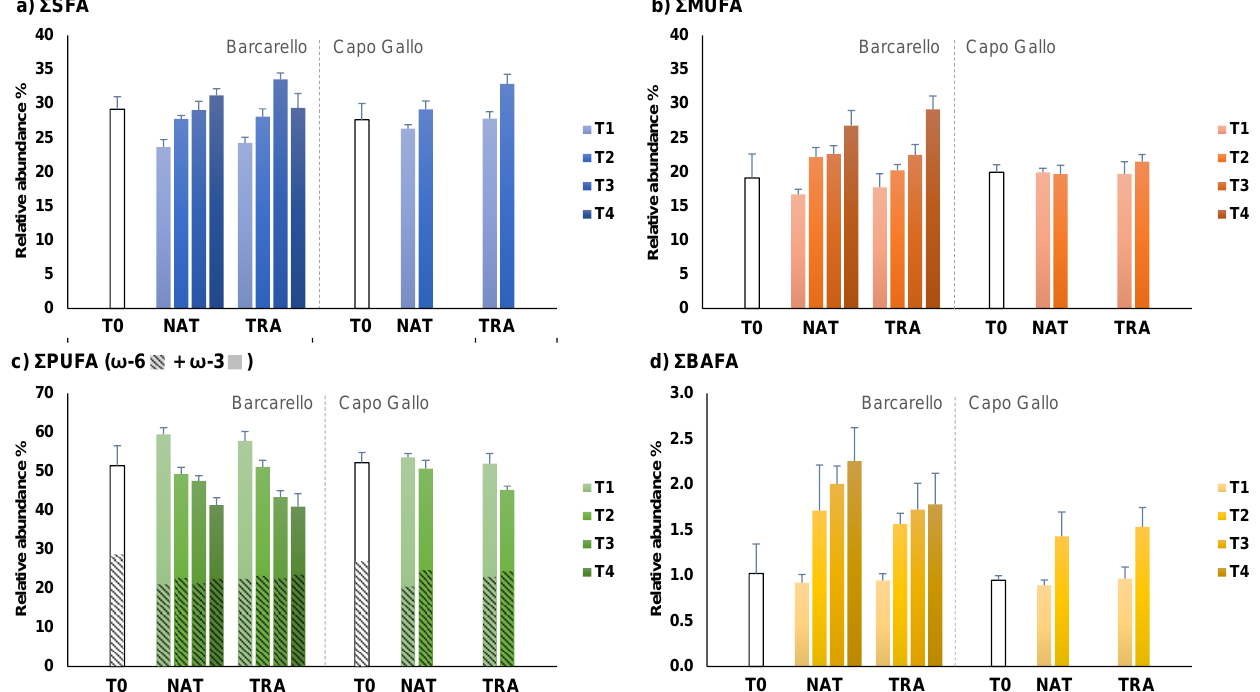
Figure 5. Relative abundance (mean ± standard deviation % of total FAs) of fatty acid classes of Ericaria amentacea at T0 and in natural (NAT) and transplanted (TRA) thalli throughout the experiment at Barcarello and Capo Gallo sites. ( a ) Sum of saturated fatty acids SFA; ( b ) sum of monounsaturated fatty acids MUFAs; ( c ) sum of polyunsaturated fatty acids PUFA with the distinction between ω -6 and ω -3; ( d ) sum of bacterial fatty acids